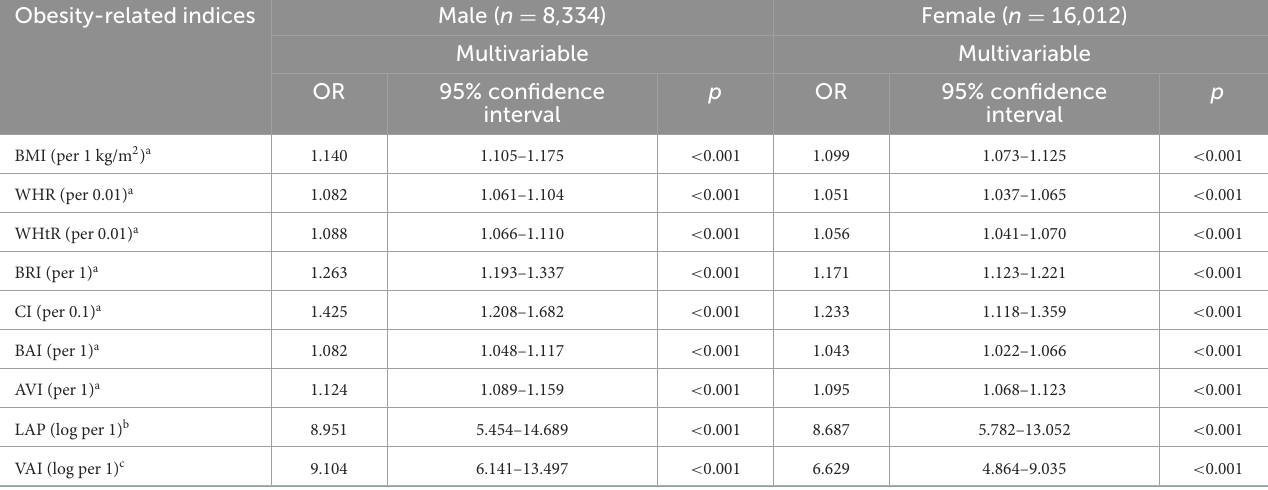
TABLE 3 Association of obesity-related indices with incidence of DM using multivariable logistic regression analysis. Obesity-related indices Male ( n = 8,334) Female ( n = 16,012) Multivariable Multivariable p OR OR 95% confidence interval